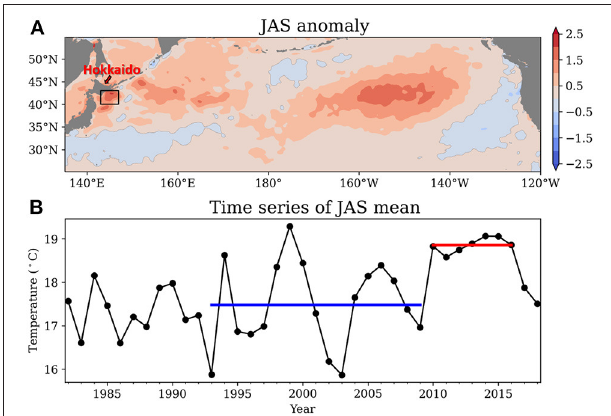
FIGURE 1 | (A) Anomaly of the 2010–2016 mean SST in July–September to the 1993–2009 mean (color; ◦ C). (B) Time series from 1982 to 2018 of the July–September mean SST ( ◦ C) averaged over the box (143–147 ◦ E 40–43 ◦ N) enclosed in black lines in (A) . The blue line shows the 1993–2009 mean; the red line shows the 2010–2016 mean. OISST version 2 (see section Data) was used for these